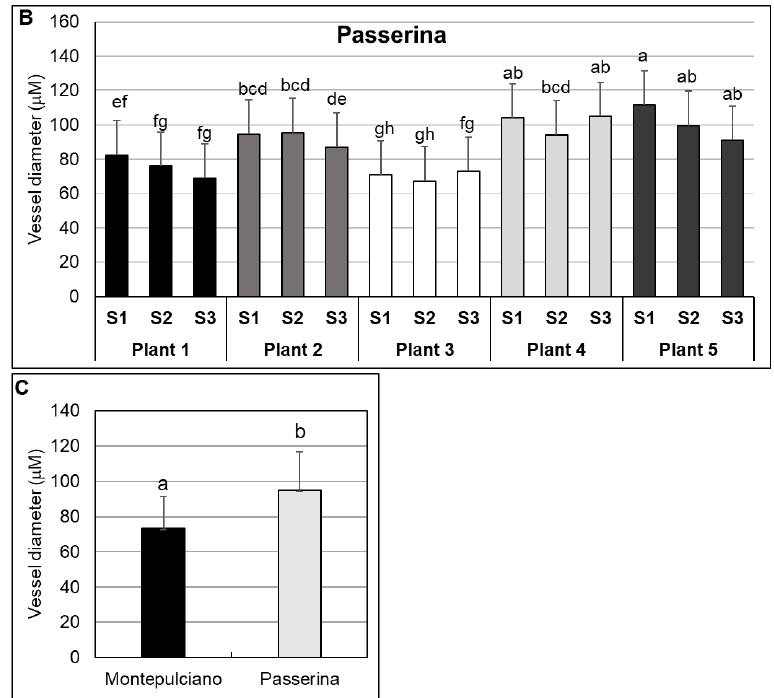
Figure 2. Quantification of vessel diameter detected in the preliminary test for ‘Montepulciano’ ( A ) and ‘Passerina’ ( B ) cultivar, relating to the singular stem (S) analysed from each plant. The average value per cultivar is also shown ( C ). Data are means ± standard deviation. Different letters above column indicate significant differences between cultivars (Fisher’s tests; p ≤ 0.05).